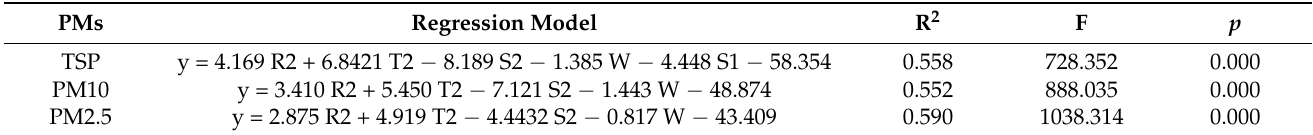
Table 13. Regression model of PM concentration.